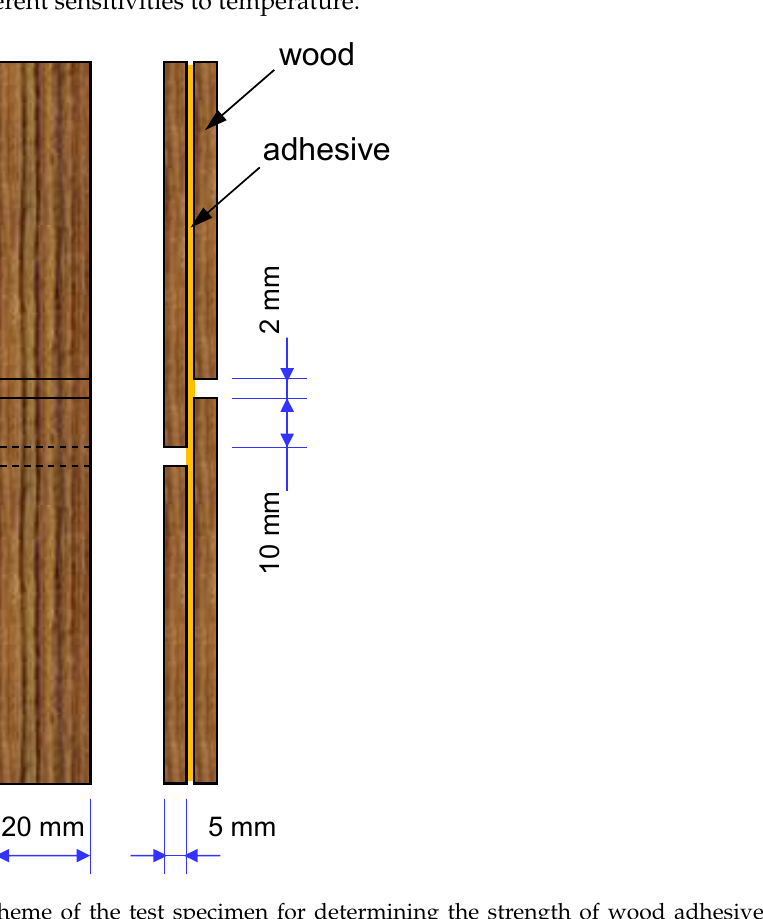
Figure 7. A scheme of the test specimen for determining the strength of wood adhesive joints according to EN 302 ‐ 1 (2013).